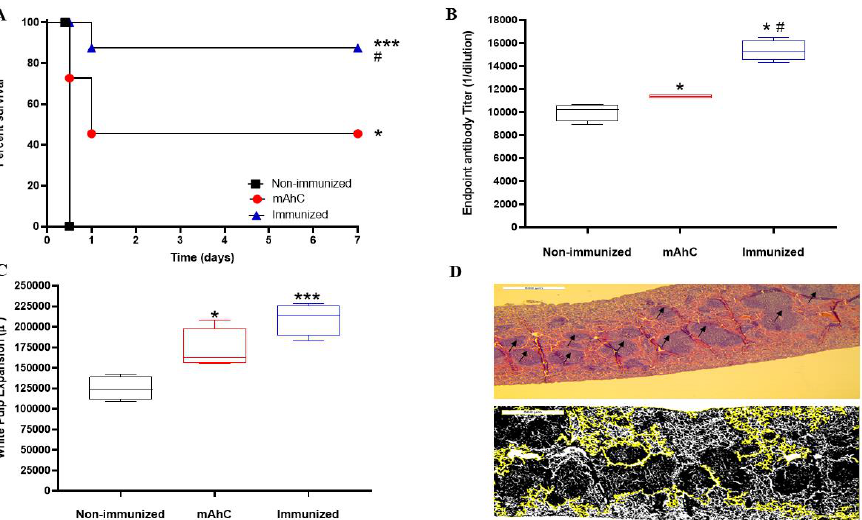
Figure 6. Efficiency test of whole-cell vaccine inactivated and adsorbed on mAhC in CY-treated mice. ( A ) Survival curve of experimental groups using CY-treated mice after a lethal dose of A. baumannii (4.0 × 10 8 CFU/mL). The log-rank test (Mantel – Cox test, with six animals per group) de- termined the p -value. (*) p < 0.05 represents a comparative analysis between non-immunized CY- treated mice vs. CY-treated mice inoculated with mAhC using six animals per group. (***) p < 0.001 represents a comparative analysis between non-immunized CY-treated mice vs. immunized CY- treated mice and ( # ) p < 0.05 represents a comparative analysis between immunized CY-treated mice vs. CY-treated mice inoculated with mAhC. ( B ) Humoral response after a lethal dose of A. baumannii (4.0 × 10 8 CFU/mL). Data refer to the total IgG levels produced from immunized CY-treated mice, non-immunized CY-treated mice, and post-lethal CY-treated mice inoculated with mAhC. (*) p < 0.05 represents a comparative analysis between non-immunized CY-treated mice vs. CY-treated mice inoculated with mAhC and non-immunized CY-treated mice vs. immunized CY-treated mice. p < 0.05 (*#) represents a comparative analysis between immunized CY-treated mice vs. CY-treated mice inoculated with mAhC. ( C , D ) Measurement and imaging of white pulp expansion of immu- nosuppressed mice. (*) p < 0.05 represents a comparative analysis between non-immunized CY- treated mice vs. those inoculated with mAhC. (***) p < 0.01 represents a comparative analysis be- tween immunized CY-treated mice vs. CY-treated mice inoculated with mAhC. ImageJ employee software is available (https://imagej.nih.gov/ij/ accessed on 31 January 2023). 3.6. Histopathological Analysis of the Sepsis Model of A. baumannii Infection in CY-Treated Mice The sepsis model of A. baumannii infection showed tissue damage in the liver, spleens, and lungs in CY-treated mice, the non-immunized mice, and the mAhC (Figure 7). By comparison, there were no significant differences between the liver and lung weights of these groups (Figure 7 A,B). In terms of the weight of the spleens of immunized CY-treated mice, there were significant differences from the non-immunized CY-treated or adjuvant groups ( p < 0.05) (Figure 7C). In addition, more substantial expansion of the white pulp was observed in this group ( p < 0.01) and the adjuvant group ( p < 0.05) (Figure 7D). The expansion of the white pulp is related to the presence of periarteriolar and follic- ular hyperplasia caused by the antigenic stimulus and immune response (Figures 6D and 7D). The histopathological findings revealed greater severity in the liver with hydropic degeneration and decreased sinusoids, and interstitial pneumonia with a mixed